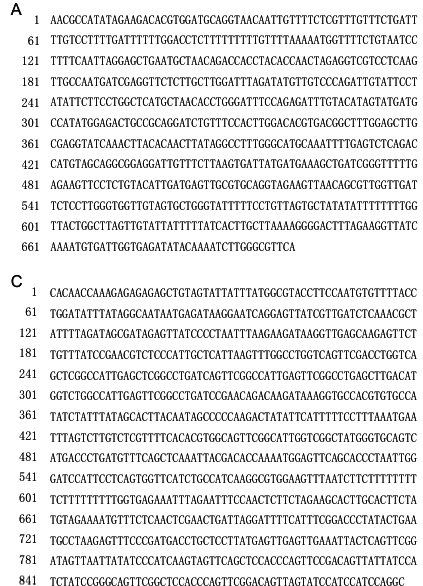
Figure 4. The cloned sequences information by Sanger-sequencing. ( A ) The sequences of clone ZZH11; ( B ) The sequences of clone ZZH31; ( C ) The sequences of clone ZZH41; ( D ) The sequences of clone ZZH51.